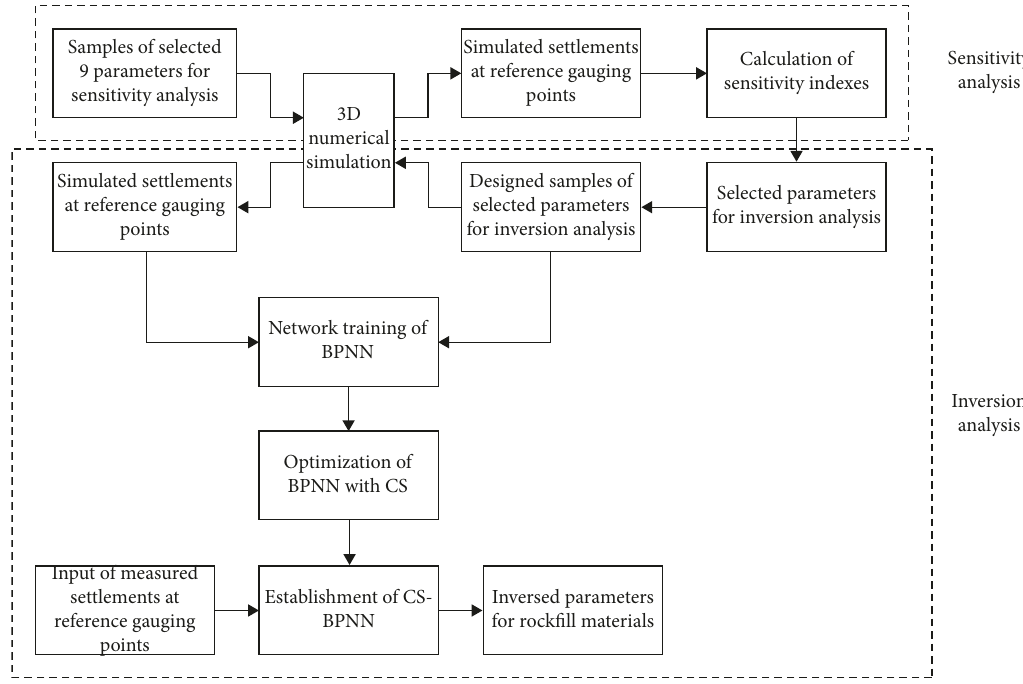
Figure 4: Flowchart of inversion analysis method for model parameters using the CS-BPNN.